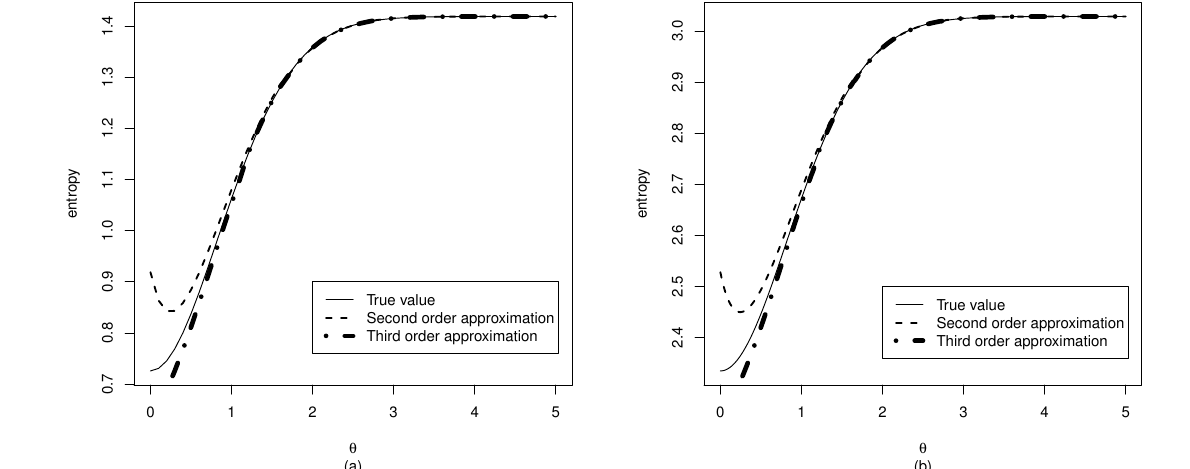
with σ = 1 ( a ) and σ = 5 ( b σ